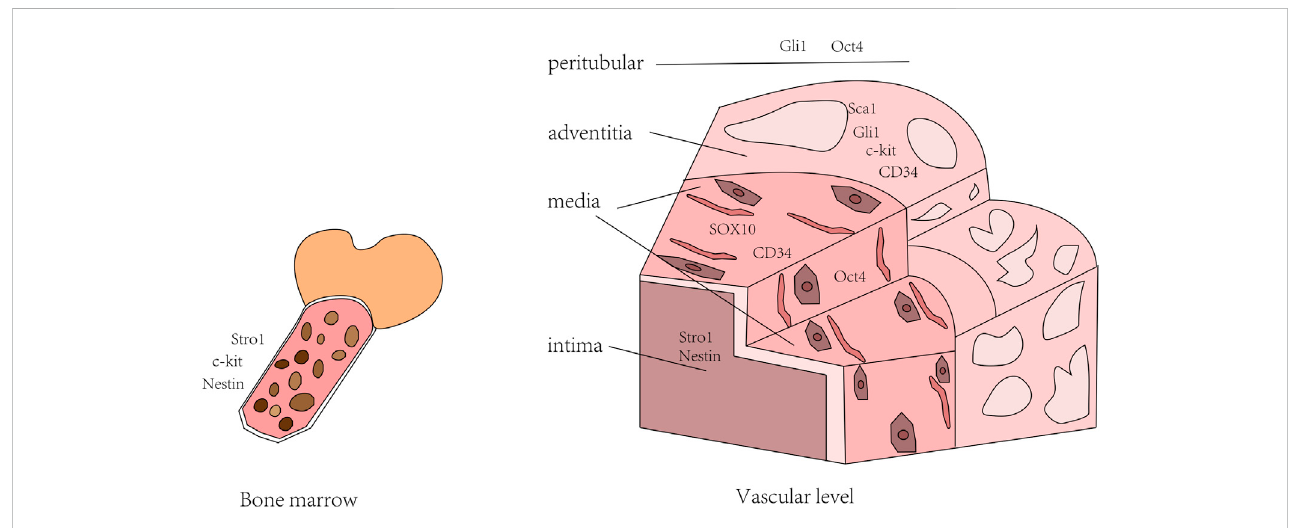
FIGURE 1 Distribution of stem cell markers in blood vessels and bone